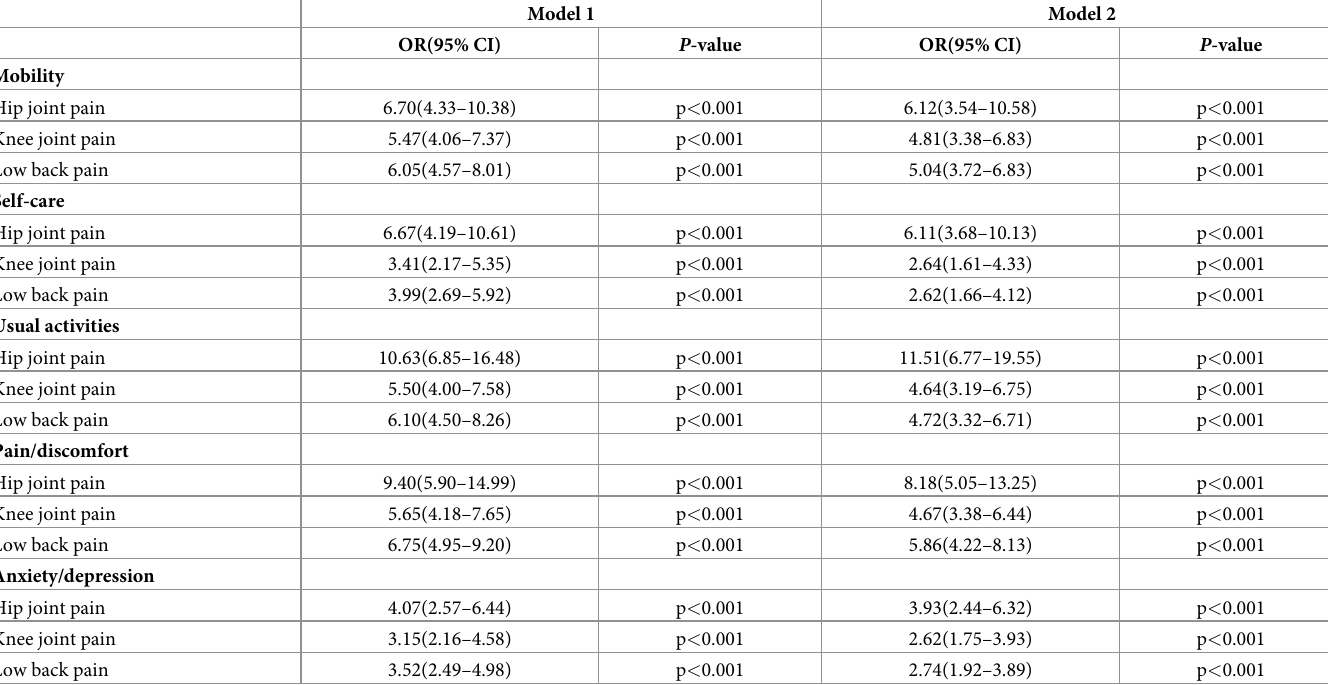
Table 4. Association between quality of life and OA pain site using multiple logistic regression analysis by